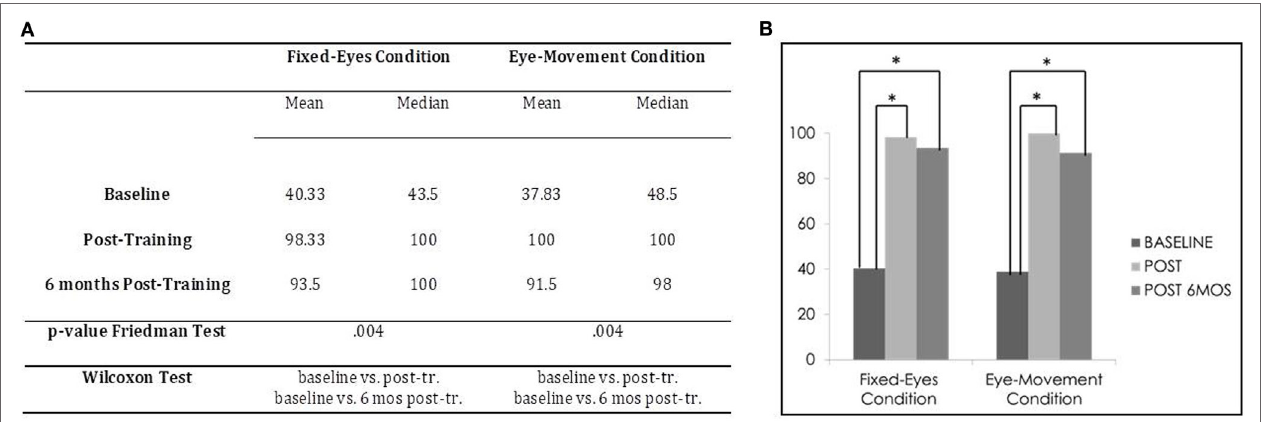
FIgUre 4 | Subject 1: unimodal Visual Test. (A) Mean and median percentages of visual detections (hemianopic hemifield) in the different evaluations, p -value of the Friedman Tests and results of Wilcoxon Tests. (B) Graphical Representation: mean percentages of visual detections ( y -axis) at baseline vs. post-training vs. 6 months post-training ( x tABle 1 | Subject 1: bimodal audiovisual test.